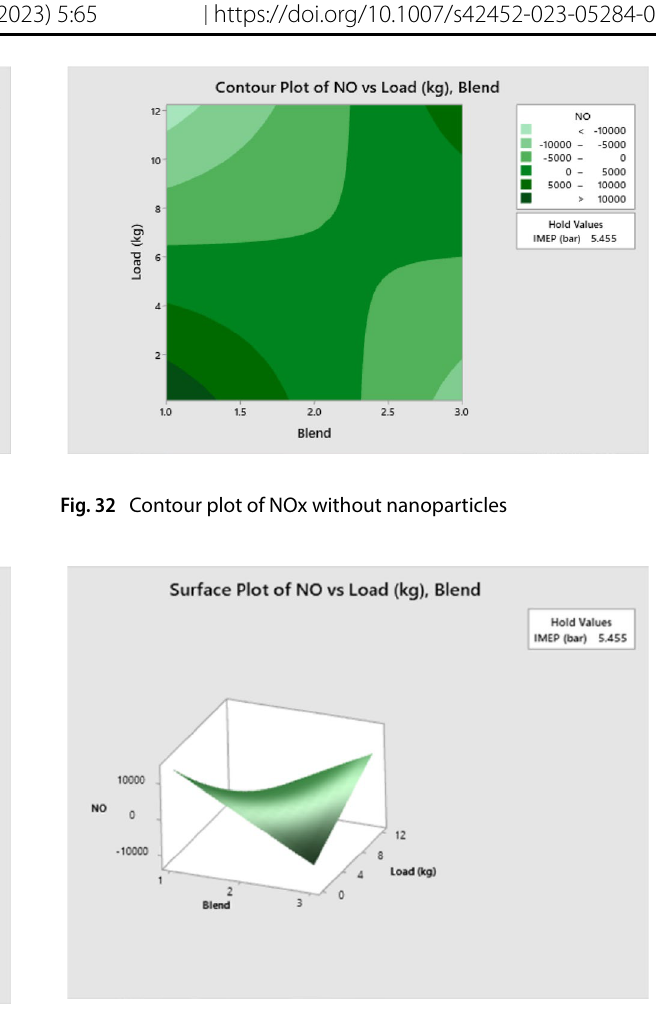
Fig. 31 Surface plot of CO